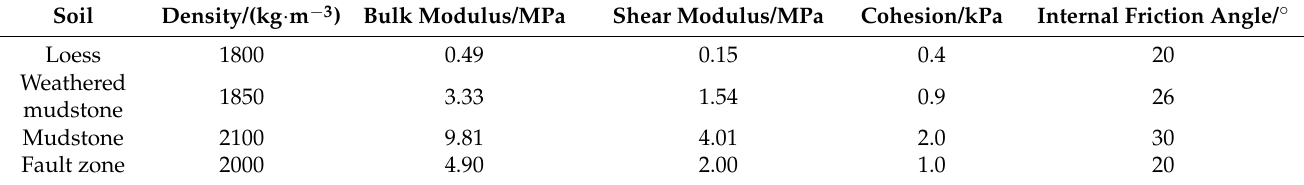
Figure 12. The numerical calculation model of loess-mudstone slope (LMS) ( a ) with a high anti-dip angle fault zone (HADAFZ) of 80° and ( b ) without the fault zone. Table 6. Basic parameters for numerical calculation.